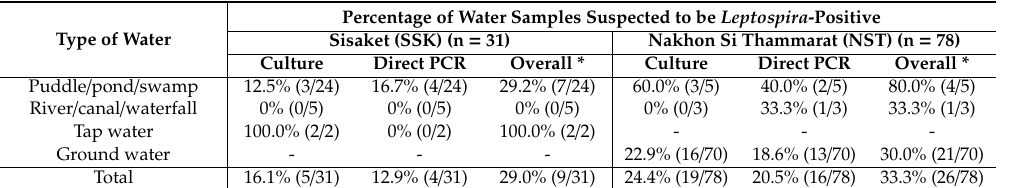
Table 2. Laboratory results of water samples collected in this study and tested for Leptospira spp. * Samples were positive by either or both culture and direct PCR.